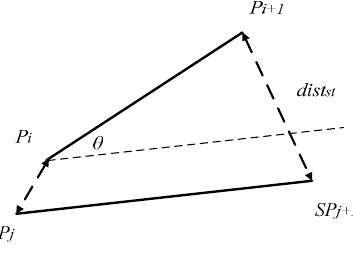
Figure 7. Segment-Segment Distance.